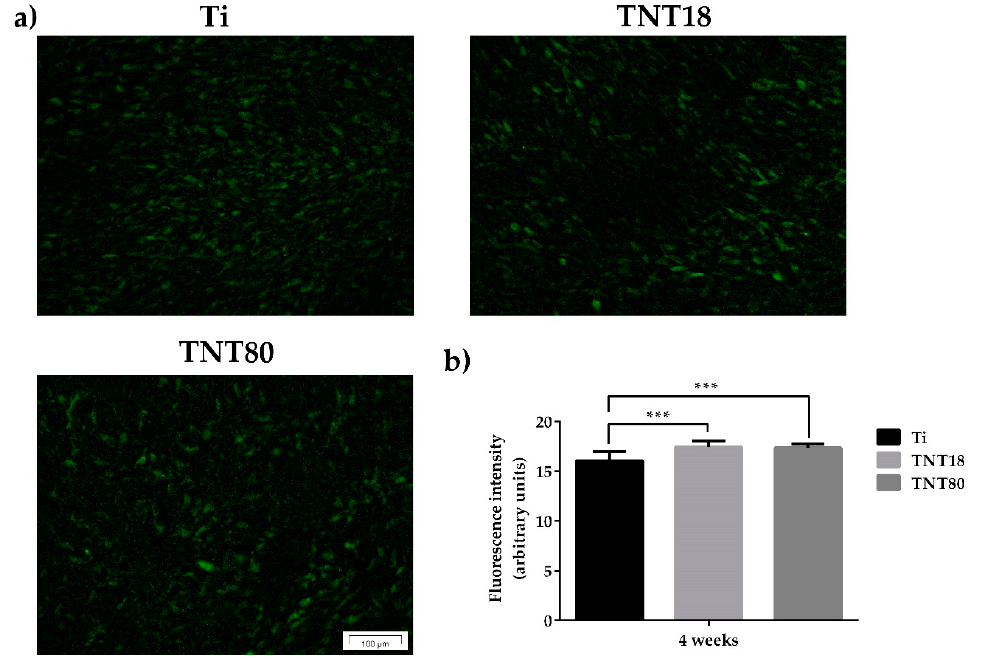
Figure 7. Evaluation of OCN expression. ( a ) Fluorescent images that highlight osteocalcin expression in MC3T3-E1 osteoblasts grown on Ti, TNT18, TNT80 surfaces for 4 weeks in the presence of osteogenic differentiation media using anti-osteocalcin (green) specific antibody; ( b ) Measurement of fluorescence intensity using Image J software (n = 20, mean ± SD, *** p < 0.001).